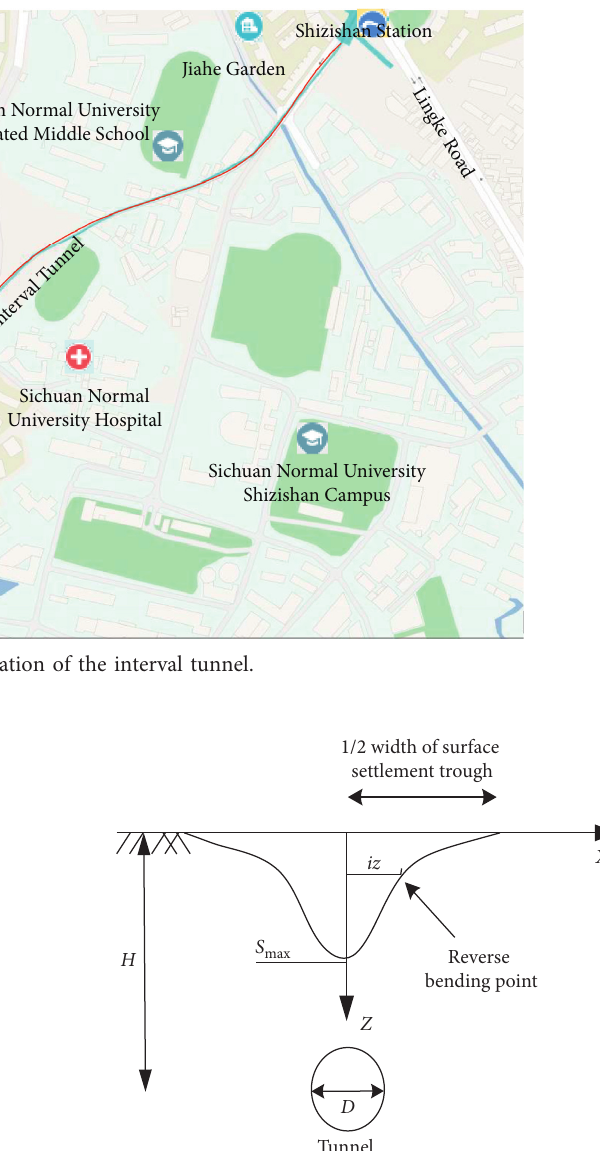
Figure 3: The diagram of Peck